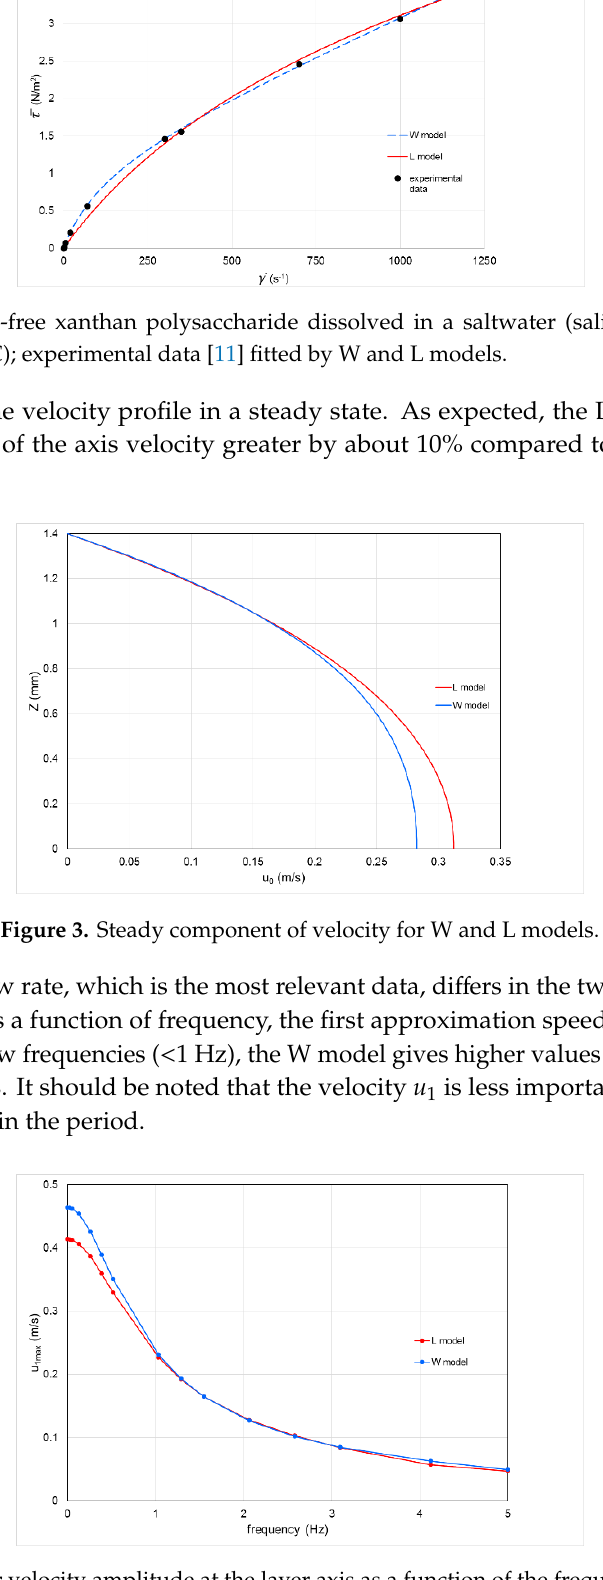
Figure 4. First-order velocity amplitude at the layer axis as a function of the frequency of disturbance for L and W models.